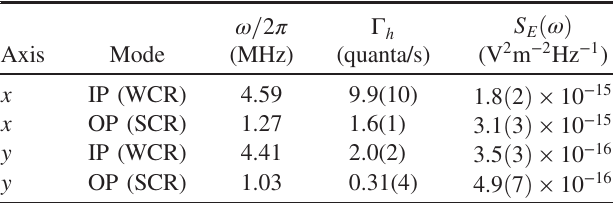
TABLE III. Properties of the four radial modes of the two-ion crystal: frequency ω = 2 π , heating rate Γ h , and calculated electric- field noise power spectral density at this frequency S E ð ω Þ